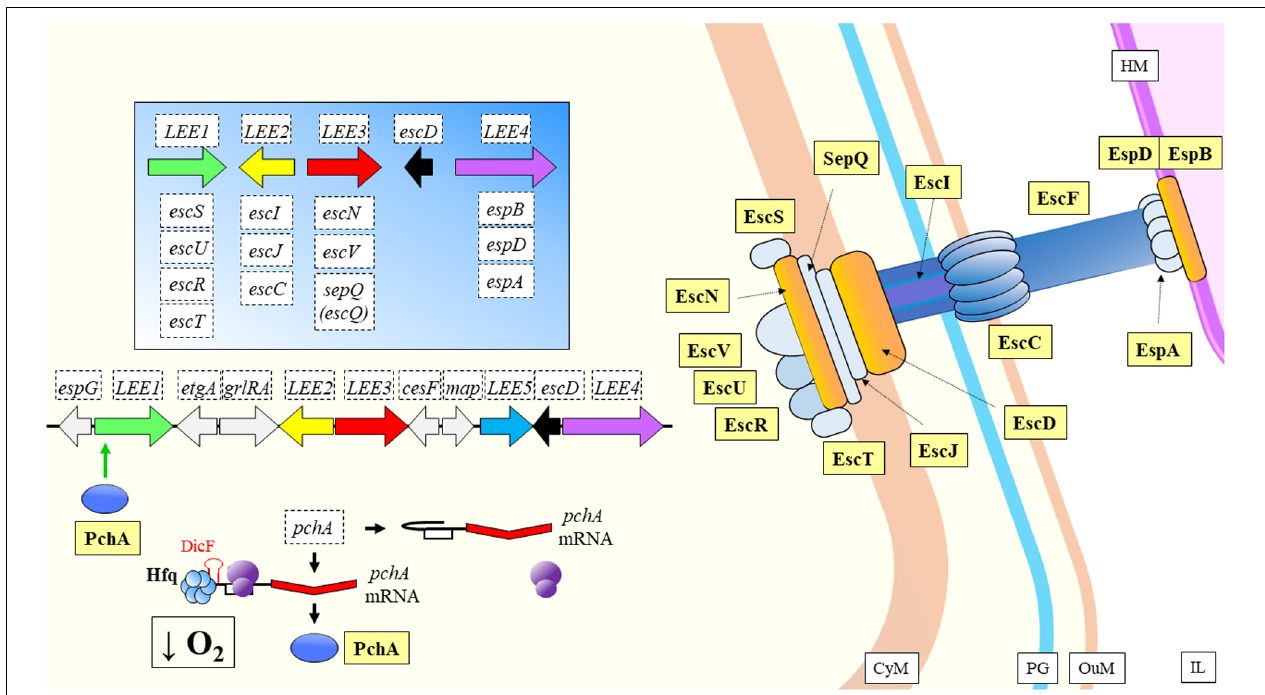
FIGURE 8 | Type III secretion system in EHEC. The pchA transcript has autoinhibitory activity, as it forms a secondary structure covering the SD site. When concentration of oxygen is low, DicF by mediation of Hfq frees the SD of pchA, allowing translation. PchA activates transcription of LEE genes involved in the synthesis of components of the T3SS. CyM, Cytoplasmic membrane; HM, Host cell membrane; IL, Gastrointestinal lumen; OuM, Outer membrane; PG, peptidoglycan; T3SS, Type III secretion system. Black thick arrows indicate flow of a biological process, e.g., protein translation. Green thick arrows